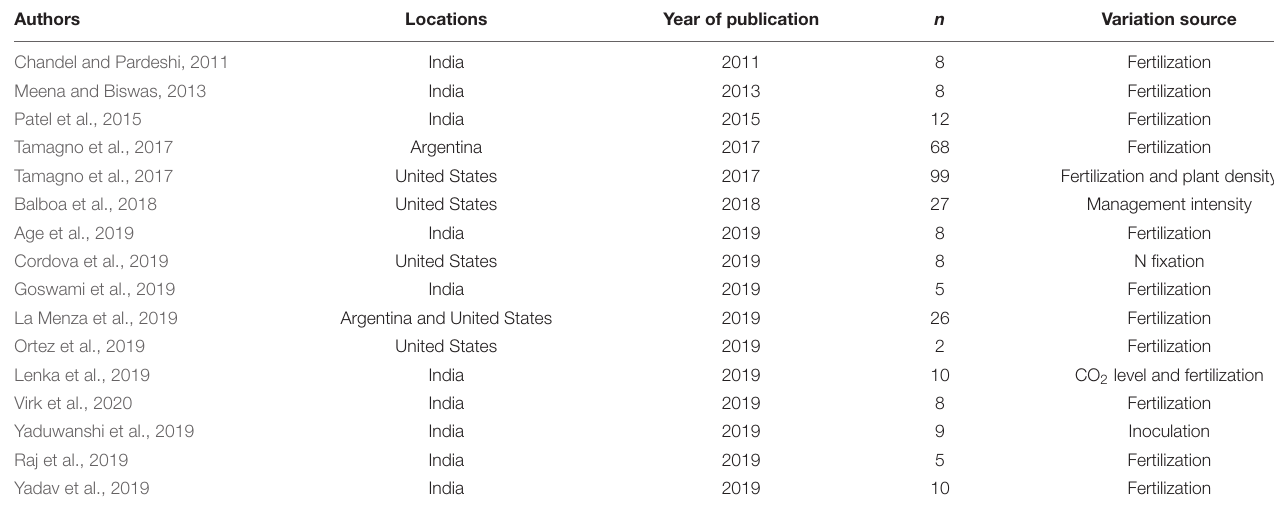
TABLE 3 | General information related to the literature